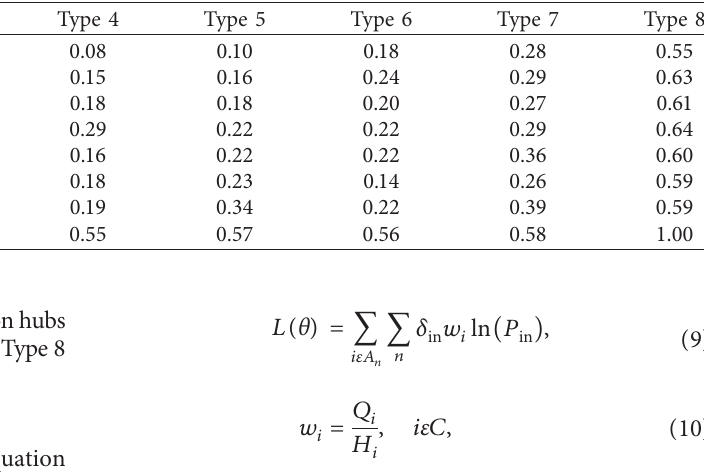
Table 4: Land matching degree values of different types of O-D